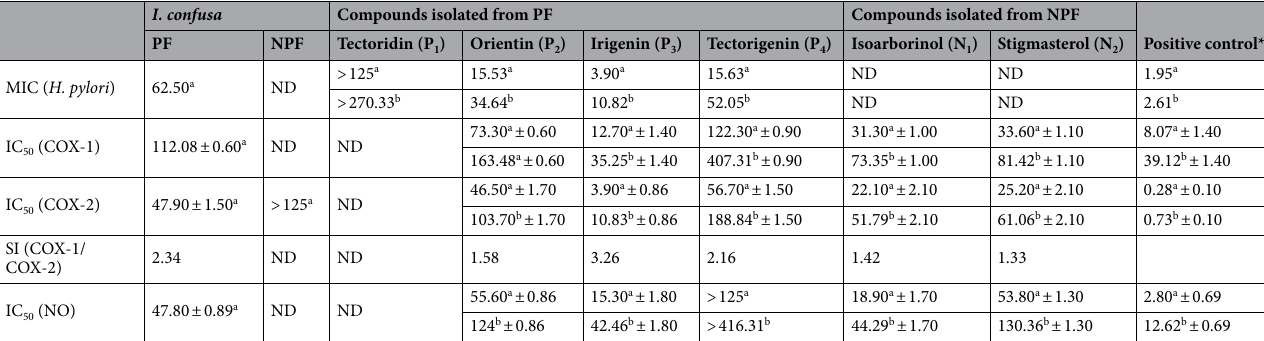
Table 1. Minimum inhibitory concentration of I. confusa underground parts PF, NPF and isolated compounds against Helicobacter pylori and their IC 50 on COX-1, COX-2, and nitric oxide (NO). a µg/mL;